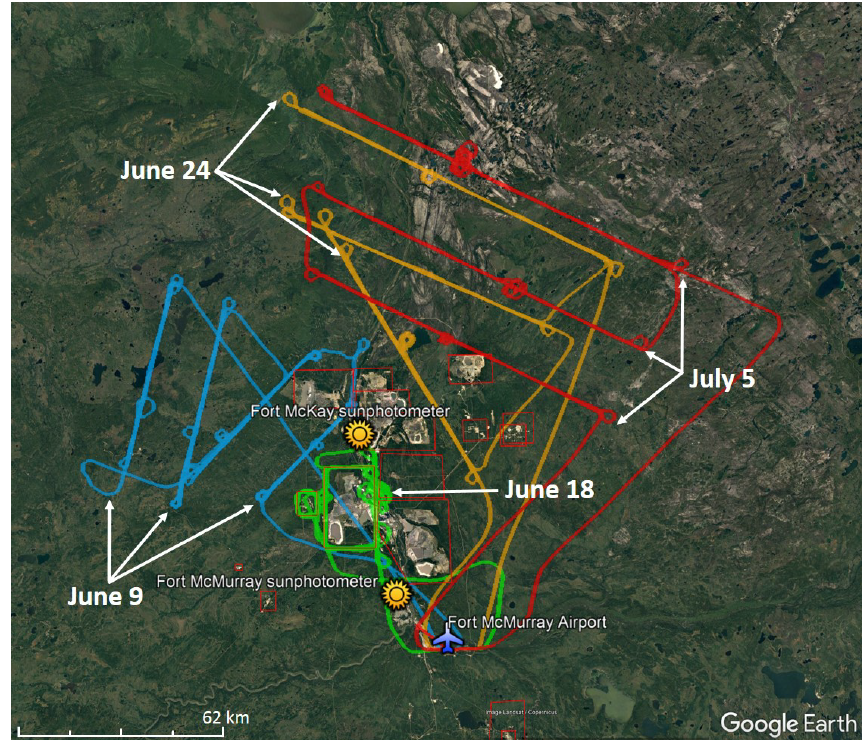
Figure 1. Selected flight tracks during the Oil Sands Measurement Campaign. Also shown are locations of AOSR facilities (red outlined boxes) and Fort McMurray and Fort McKay AERONET stations overlaid on satellite imagery (image source: Landsat/Copernicus as used by © Google